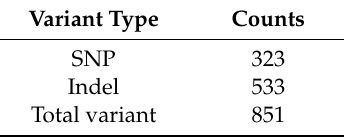
Table 3. Summary of variants analysis in heterozygous sites of the B. naardenensis CBS 7540 genome.